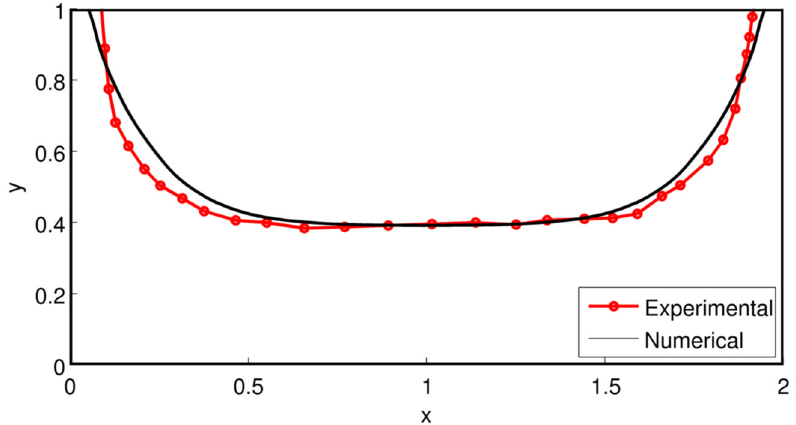
Figure 29. Coextrusion of two polystyrene in a slit die of rectangular cross-section: Comparison between the experimental data of Teixeira-Pires (Reprinted from [44]) and the numerical computations of Borzacchiello (Reprinted from